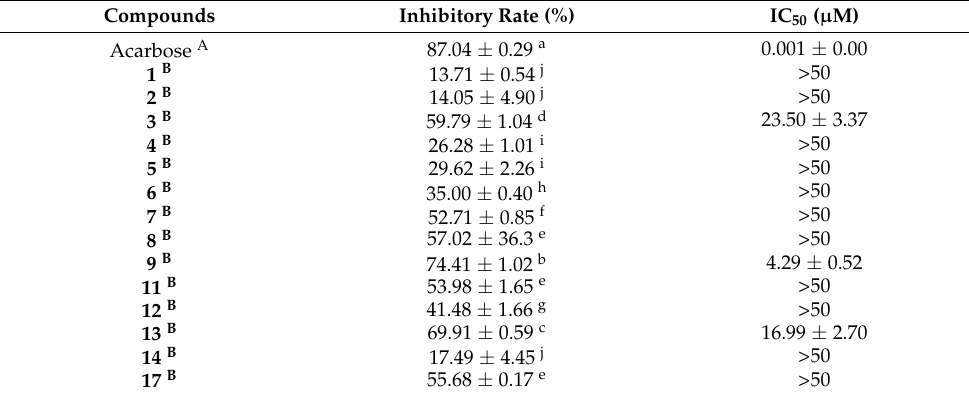
Table 3. α -Glucosidase inhibitory activities of compounds 1 − 9 , 11 − 14 , and 17 . Compounds